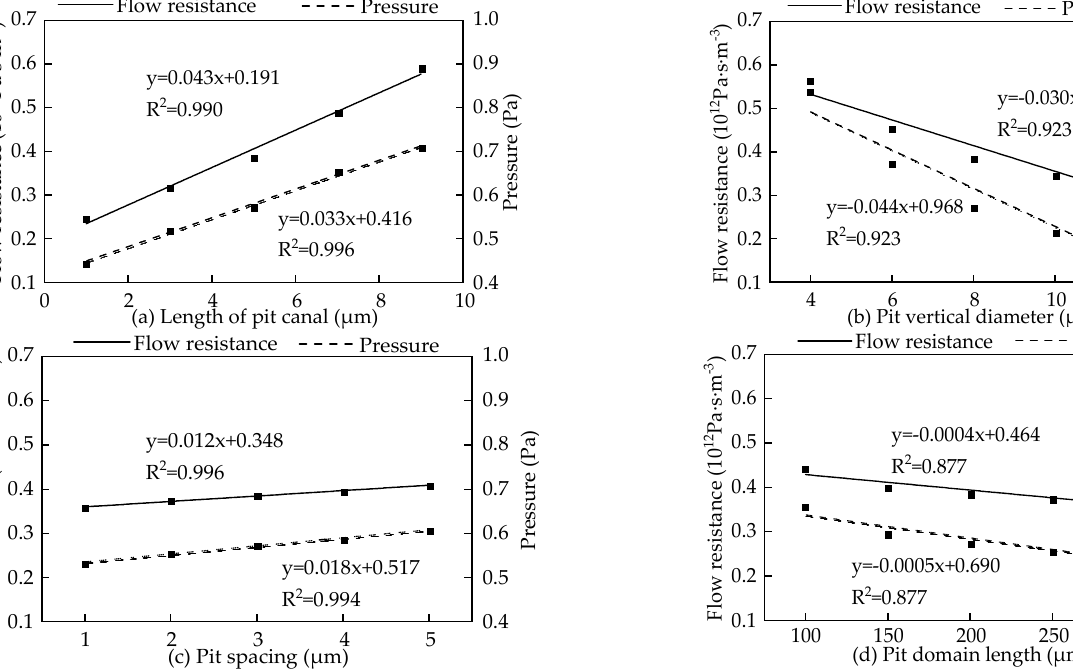
Pressure Figure 8. Flow resistance trends of the scalariform perforation plate structure. 3.3.3. Influence of the Pit Structure on the Flow Resistance It can be seen from Figure 9 that the flow resistance and the pressure drop ( Δ p) had a near linear relationship with the length of the pit canal, the pit vertical diameter, the pit spacing, and the pit domain length; the determination coefficients (R 2 ) were 0.990 (0.996), 0.923 (0.923), 0.996 (0.994), and 0.877 (0.877), respectively, indicating that the equations were fitted well. The flow resistance increased with the increase in length of pit canal and pit spacing and decreased with the increase in pit vertical diameter and pit domain length. The parameters of the other structures of the vessel remained unchanged. When the length of the pit canal was increased from 1 to 9 μ m, the flow rate (q) decreased from 1.80 × 10 − 12 to 1.20 × 10 − 12 m 3 /s, the total pressure drop ( Δ p) increased from 0.445 to 0.708 Pa and the flow resistance increased from 0.247 × 10 12 to 0.590 × 10 12 Pa·s·m − 3 , increased by 138.9%. When the pit vertical diameter was increased from 4 to 12 μ m, the flow rate (q) was stable at 1.49 × 10 − 12 m 3 /s, the total pressure drop ( Δ p) decreased from 0.839 to 0.479 Pa and the flow resistance decreased from 0.564 × 10 12 to 0.322 × 10 12 Pa·s·m − 3 , which decreased by 42.9%. When the pit spacing was increased from 1 to 5 μ m, the flow rate (q) was stable at